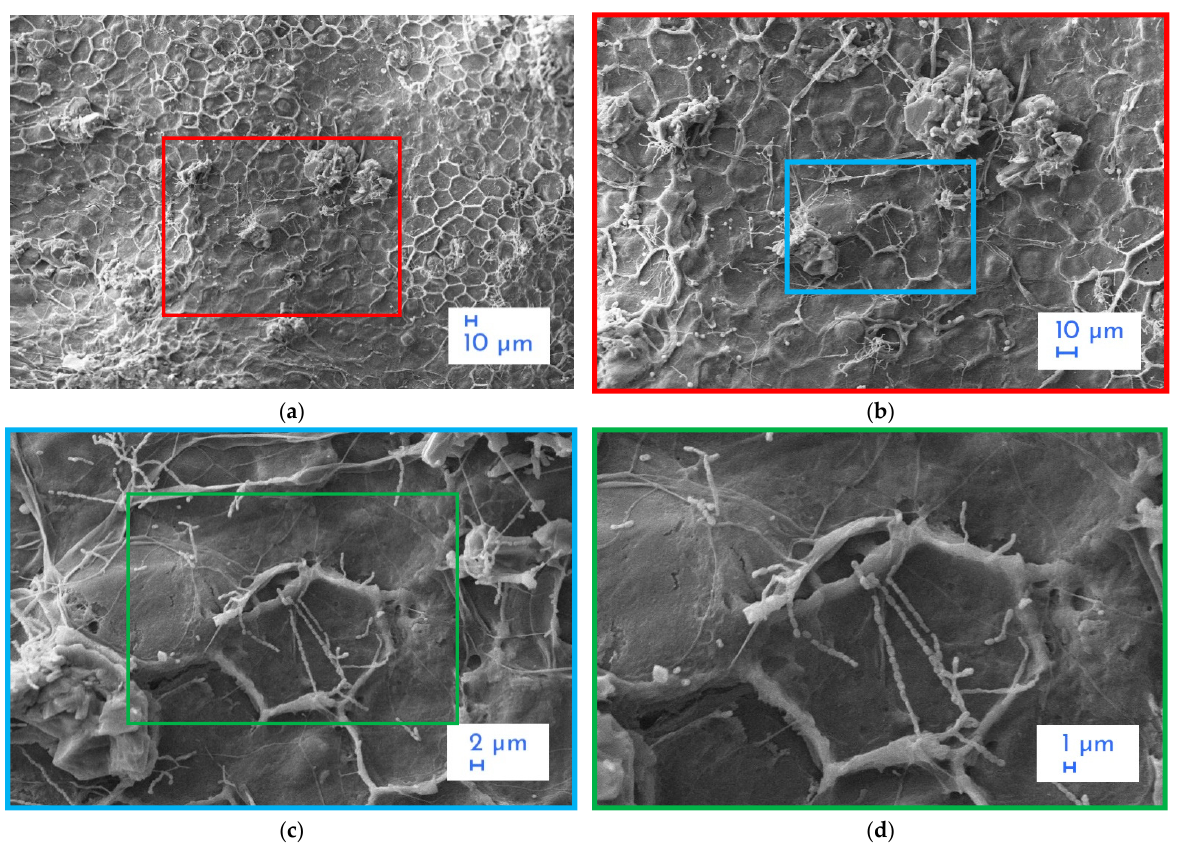
Figure 3. Bark surface of T. indica with the magnifications of ( a ) 500× ( b ) 1000× ( c ) 3000× and ( d ) 5000×. ( d ) 5000 ×